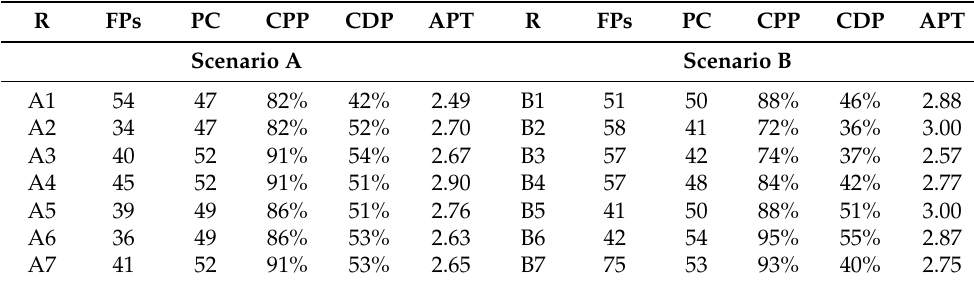
Table 6. Three MS results. Legend: R—Run; FPs—False Positives; PC—Predicted Collisions; CPP— Collision Prediction Percentage; CDP—Correct Decision Percentage; APT—Average Prediction Time (s).